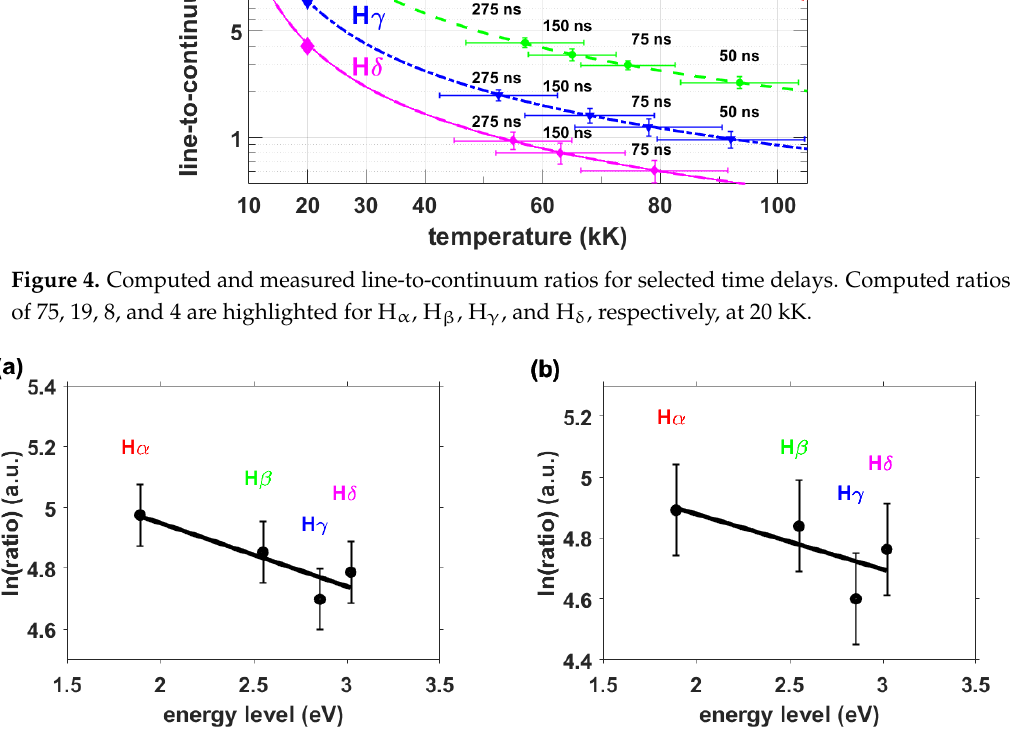
Figure 5. Boltzmann plots: ( a ) T = 55 kK, time delay: 275 ns; and ( b ) T = 64 kK, time delay: 150